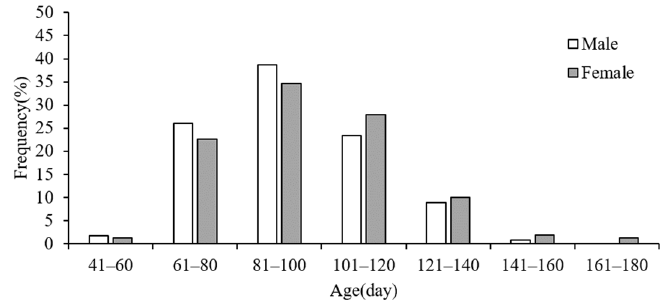
Figure 4. Age frequency distribution of B. magister shevtsovi by sex.